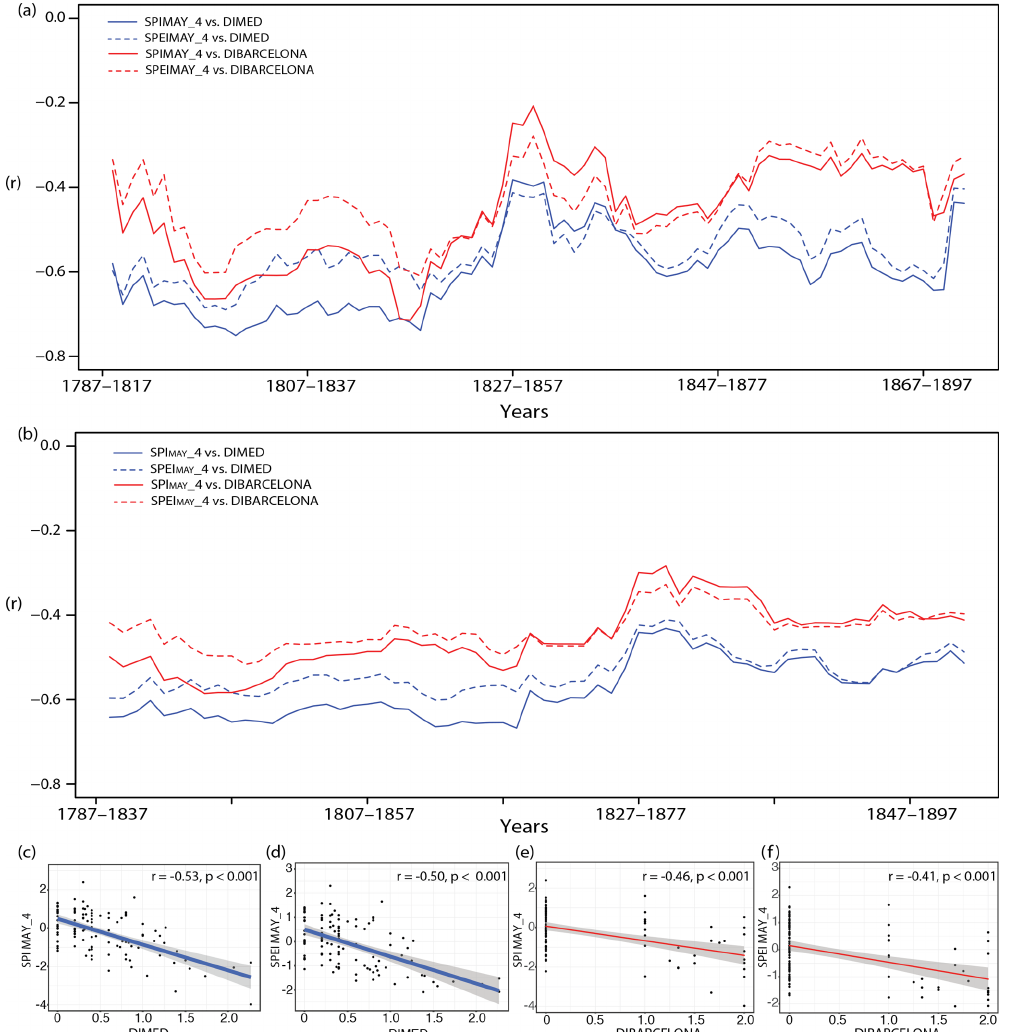
Figure 5. (a) 30-year moving correlation between DIMED, DIBARCELONA, and the instrumental computed SPI and SPEI. (b) Same but for 50-year moving correlations. (c) Correlation (Spearman) between DIMED and SPI MAY_4 for the full period (1787–1899). (d) Correlation between DIMED and SPEI MAY_4 for the full period (1787–1899). (e) Correlation between DIBARCELONA and SPI MAY_4 for the full period (1787–1899). (f) Correlation between DIBARCELONA and SPEI MAY_4 for the full period